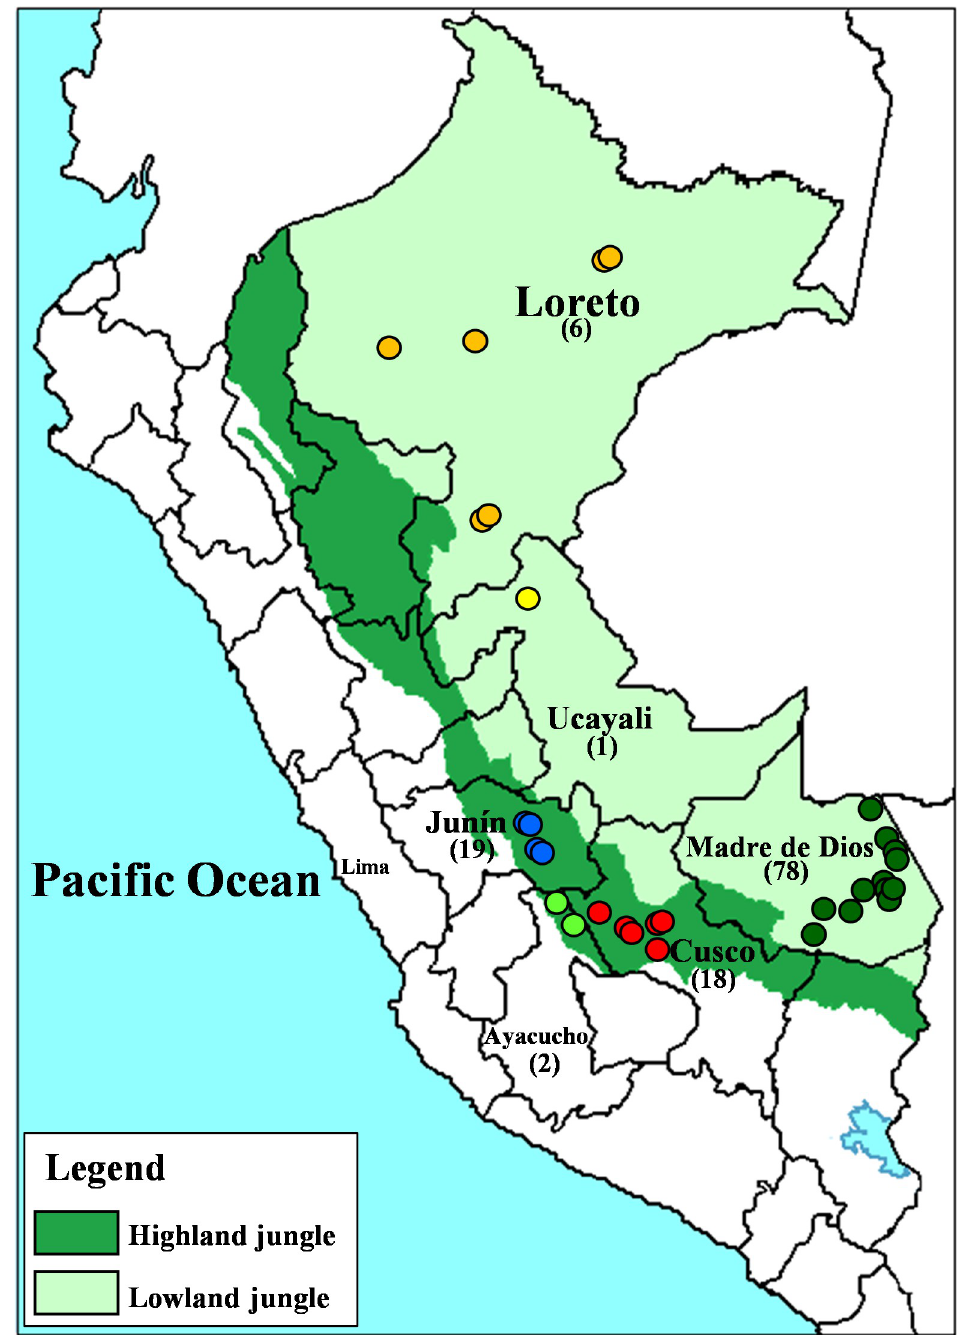
Fig 1. Map of Peru indicating the ecological regions of the highland jungle or Rupa-Rupa (dark green) and the lowland jungle or Omagua (light green), on which the divisions by departments are superimposed. The collection sites of the L . (V . ) braziliensis strains are indicated by colored circles. Loreto in orange, Ucayali in yellow, Madre de Dios in dark-green, Junı´n in blue, Ayacucho in light-green and Cusco in red. (Modified from a map available at d- maps.com https://dmaps.com/carte.php?num_car=4765&lang=en).